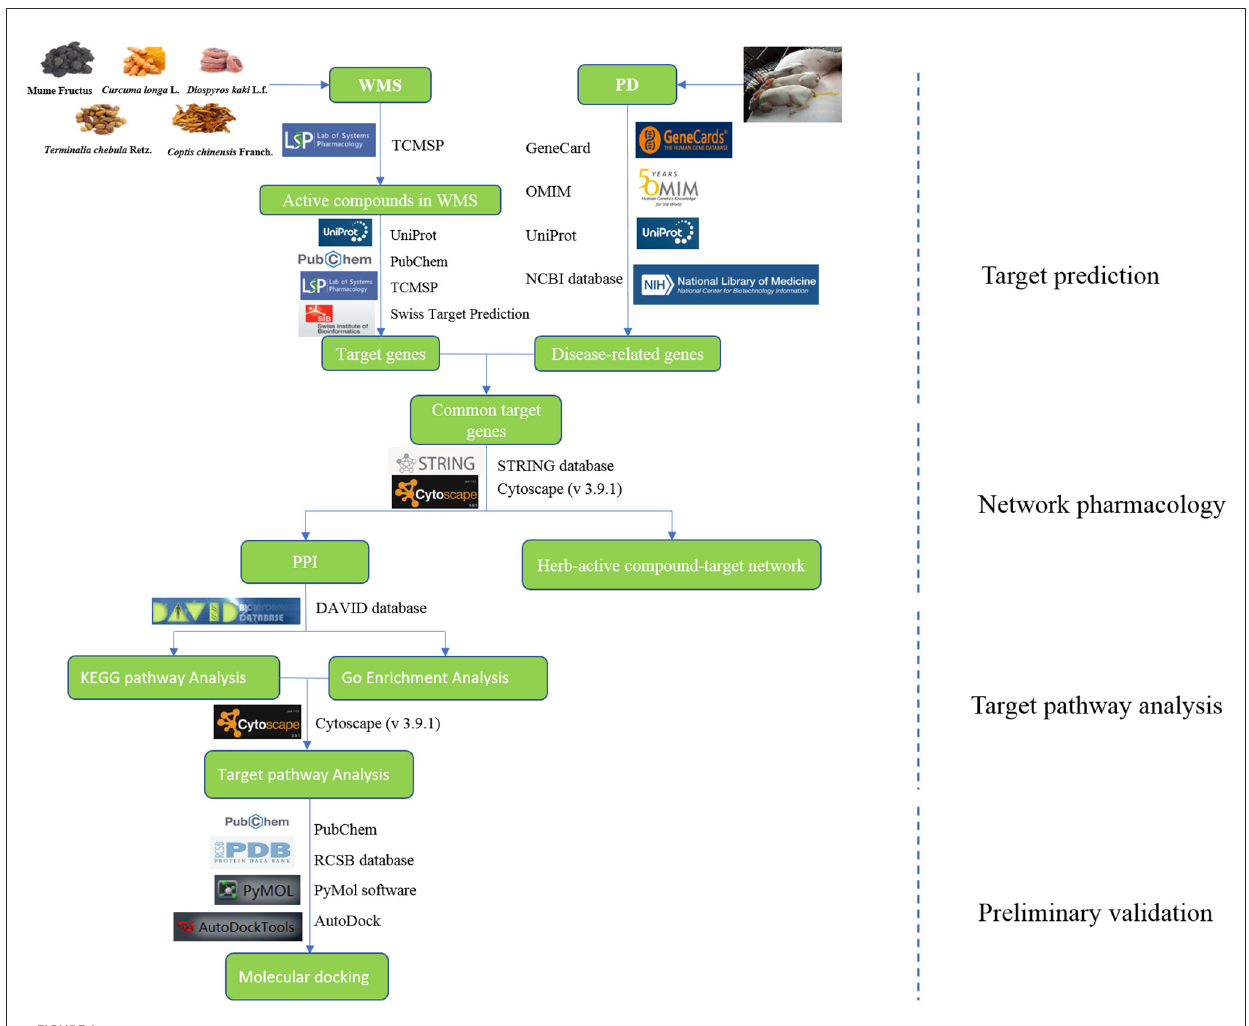
FIGURE1 The flowchart of this study.